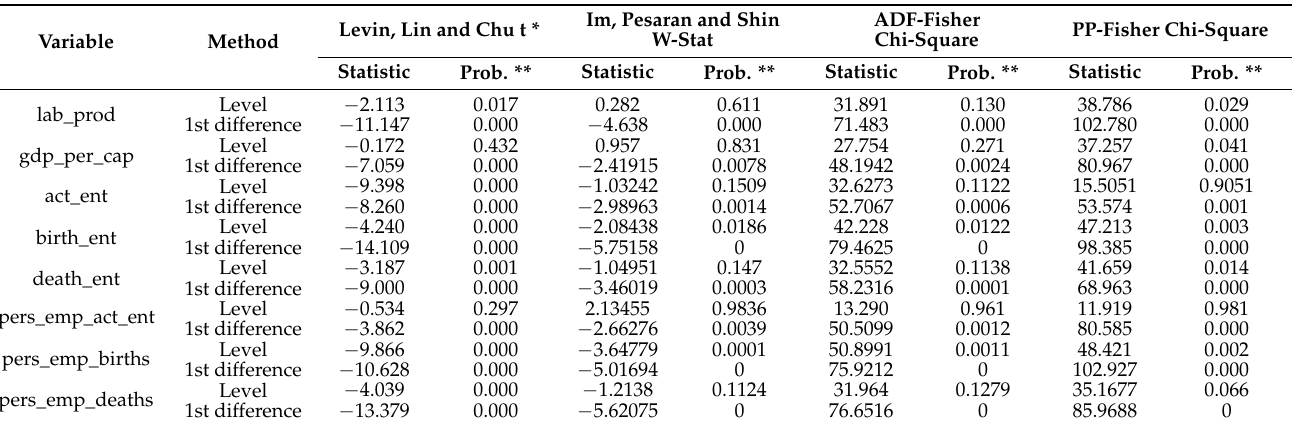
Table 9. Panel unit root tests